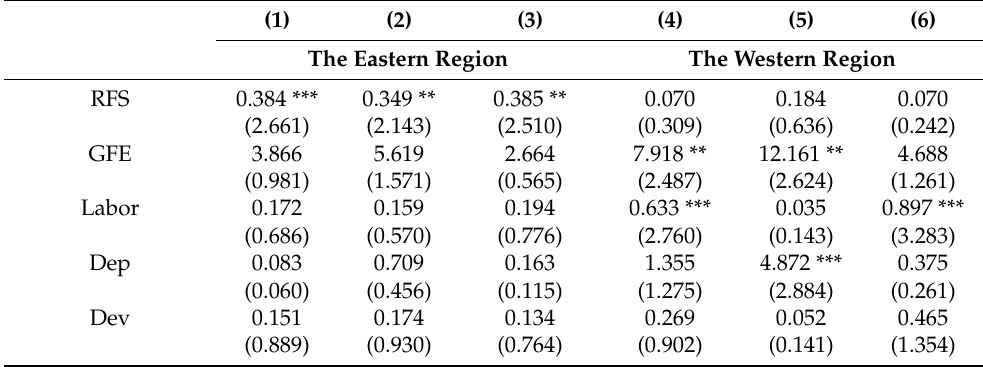
Table 8. Financial Scale, Regional Distribution, and Agricultural Technology